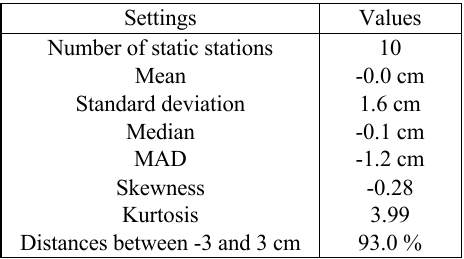
Figure 8. Representation of the M3C2 distances between the complete MMS acquisition and all SLS stations.